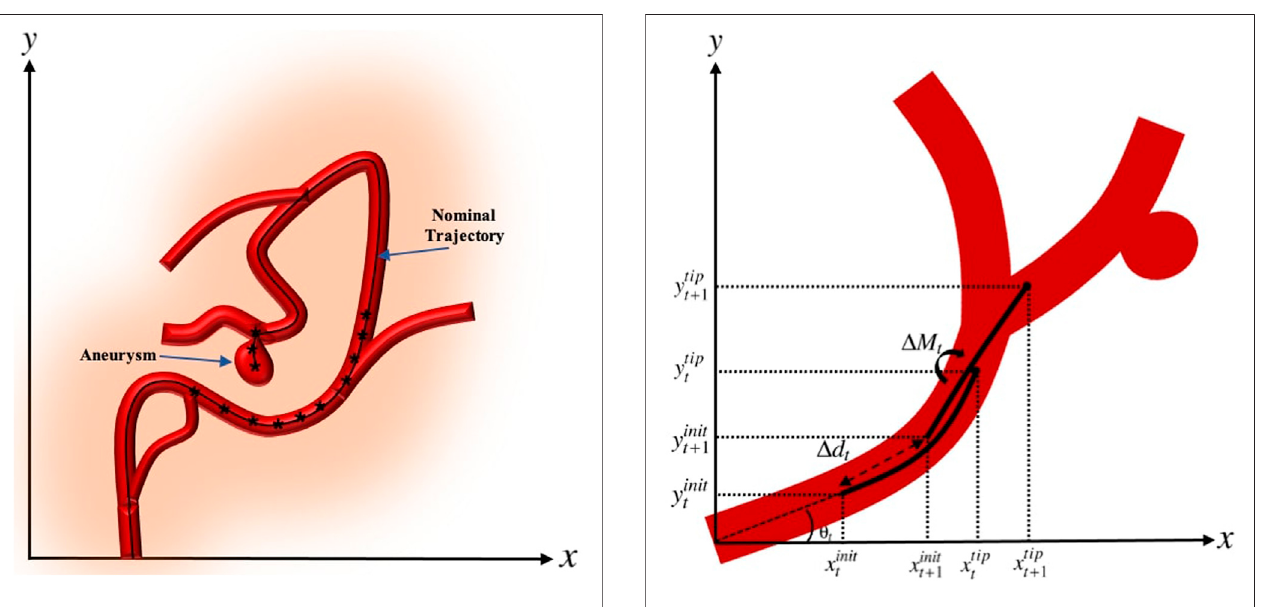
Frontiers in Robotics and AI |